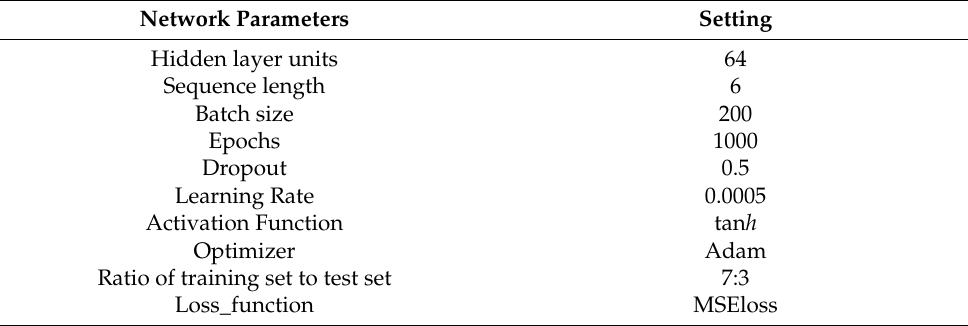
Table 4. BiGRU network structure parameters.